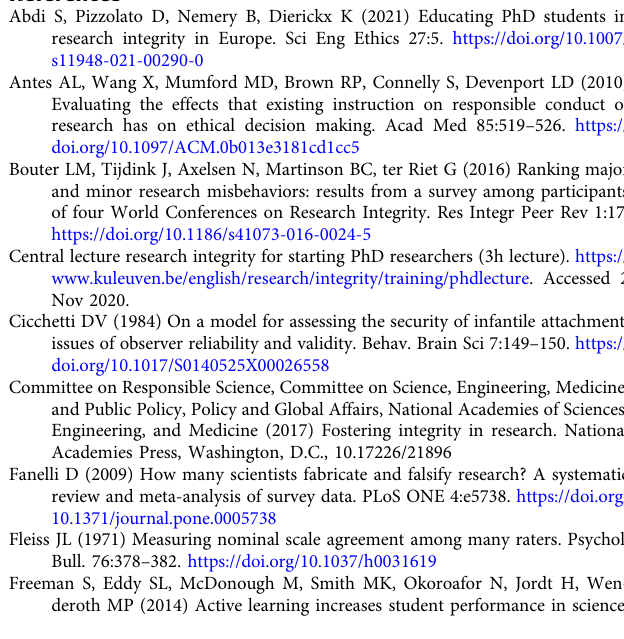
(see Supplementary material 1).